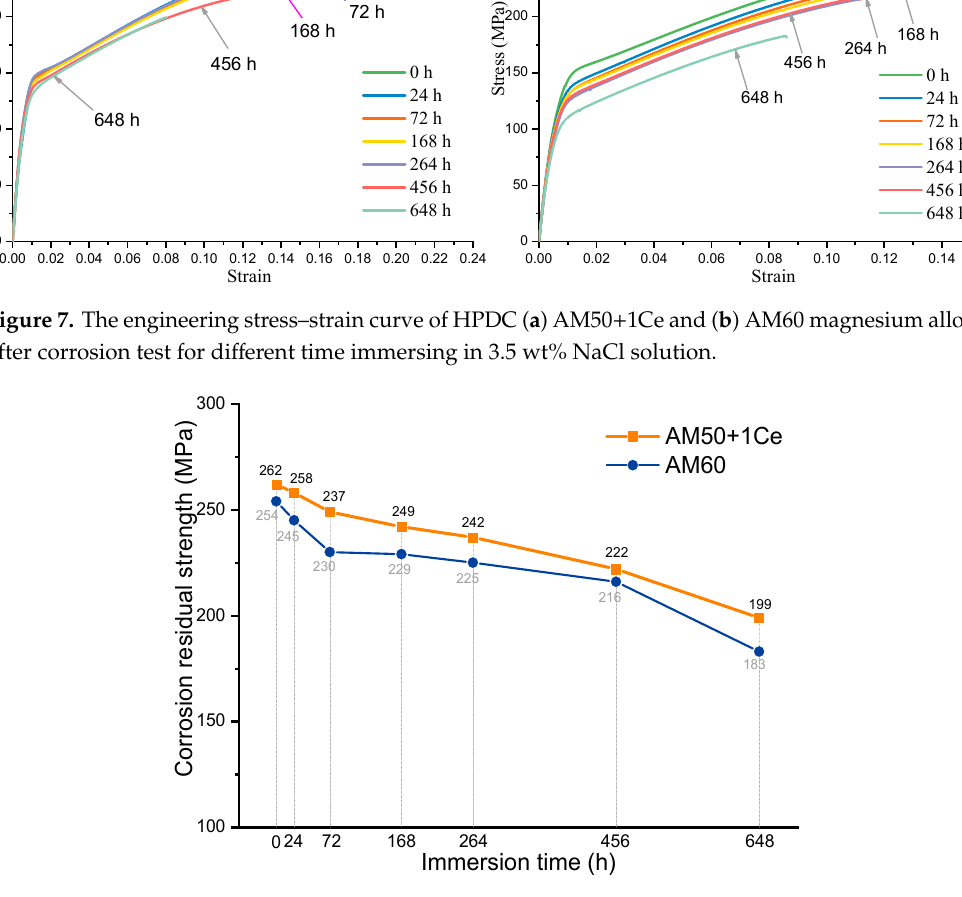
Figure 8. The corrosion residual strength comparison of HPDC AM50 + 1Ce and AM60 magnesium alloy for different corrosion times.